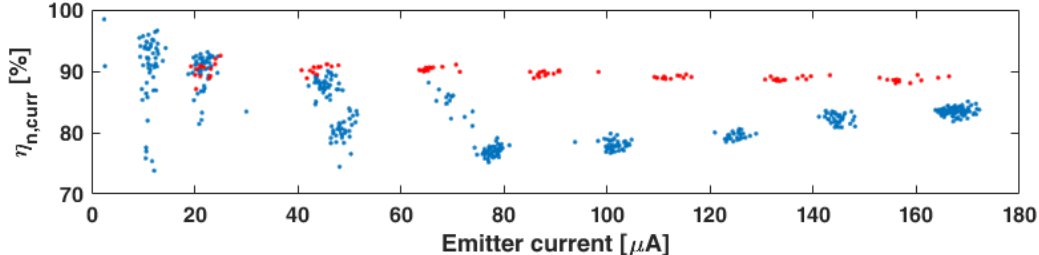
Figure 8. Neutralizer current efficiency according to laboratory experiment on 18 October 2018 in blue. In-orbit data of the neutralizer from 28 March 2020 in